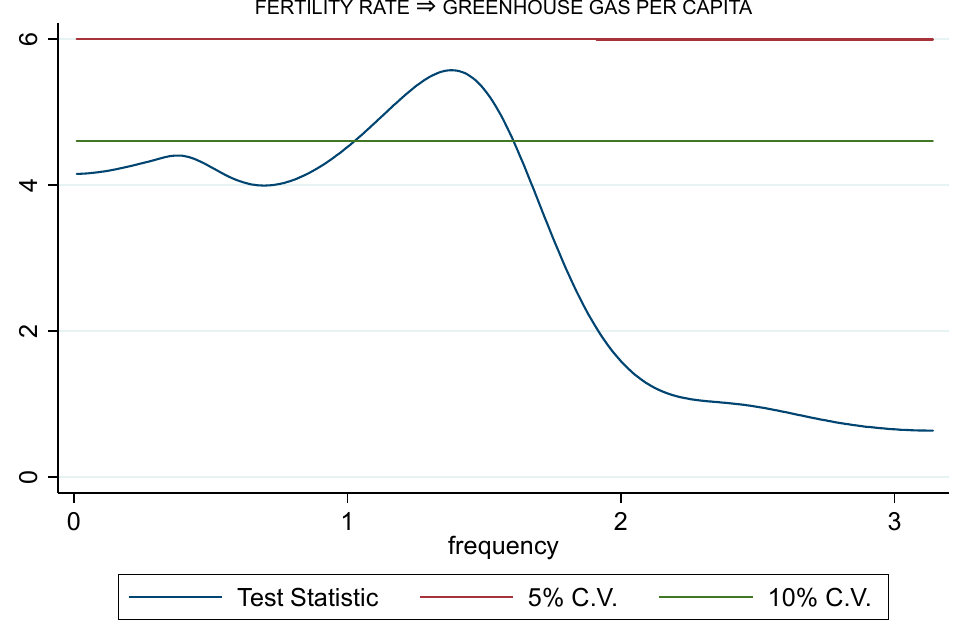
Figure 4. Evidence of causality from fertility rate to GHG per capita emissions in Sweden.